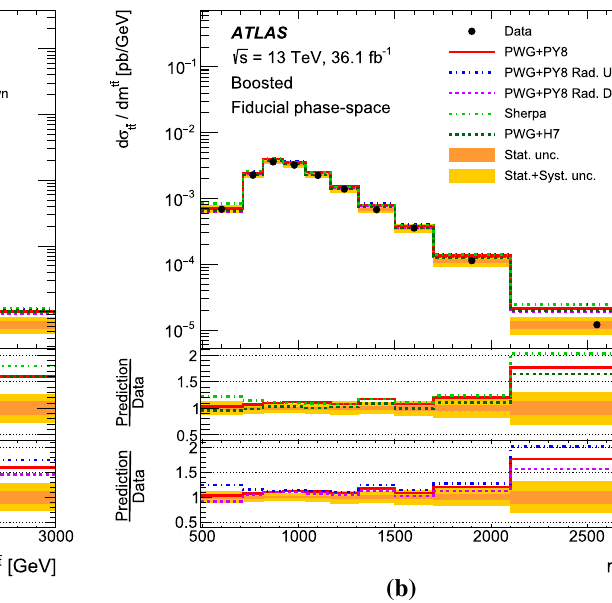
and total uncertainty in the data. Data points are placed at the centre of each bin. The lower panel shows the ratios of the simulations to